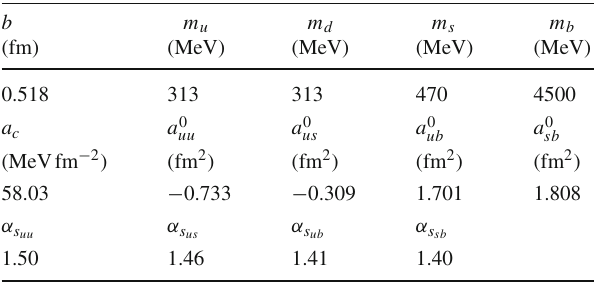
Table 1 Model parameters: m π = 0 . 7 fm − 1 , m K = 2 . 51 fm − 1 , m η